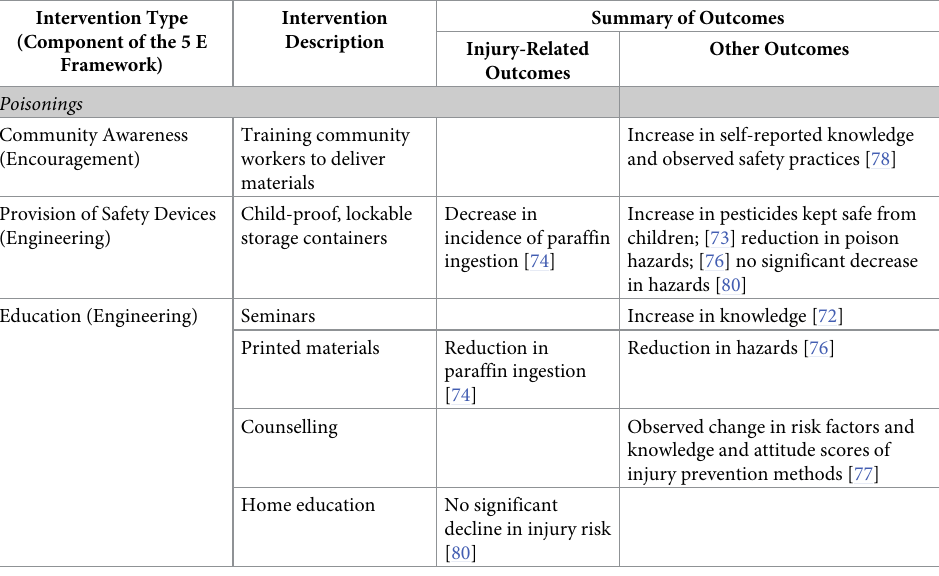
Table 5. Summary of intervention outcomes for injury types: Poisonings.